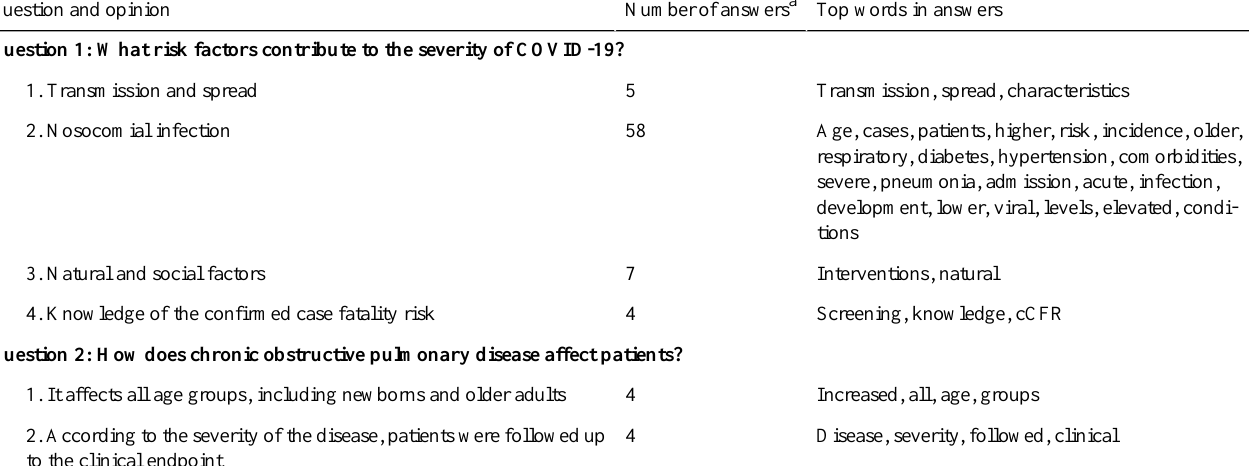
Table 3. Opinions, the number of answers supporting every question, and the words with the highest frequency for each opinion in the articles published since